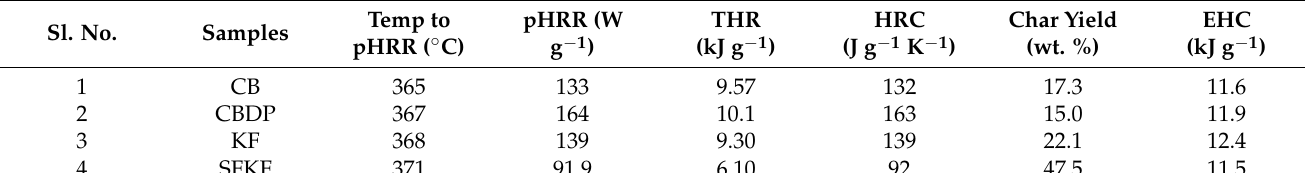
Table 4. The relevant parameters from the PCFC runs.